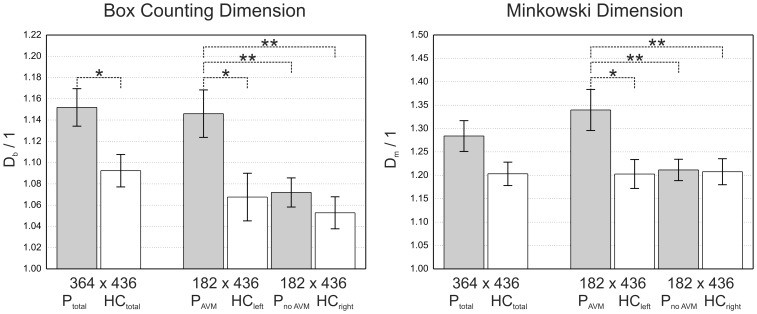
Mean values and standard error mean of Db (left side of the figure) and Dm (right side of the figure) comparing patients (Ptotal) with healthy controls (HCtotal) for the whole image, hemispheres of patients with AVM (PAVM) compared to the hemisphere without AVM (Pno AVM) and comparison of the left and right hemisphere of healthy controls (HCleft, HCright).Asterisks indicate significant differences in group comparisons: * p<0.05, ** p<0.01.